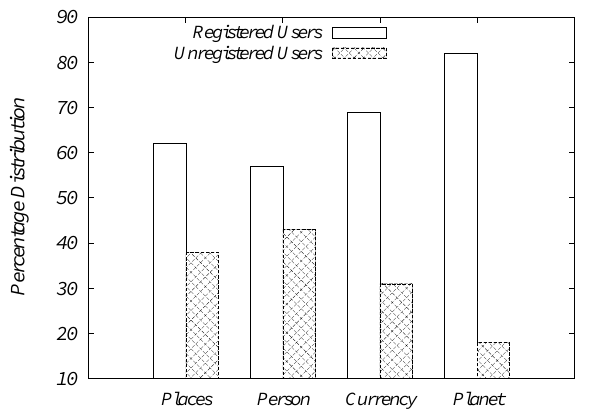
Figure 6. Registered and Unregistered Contributions for Vandal